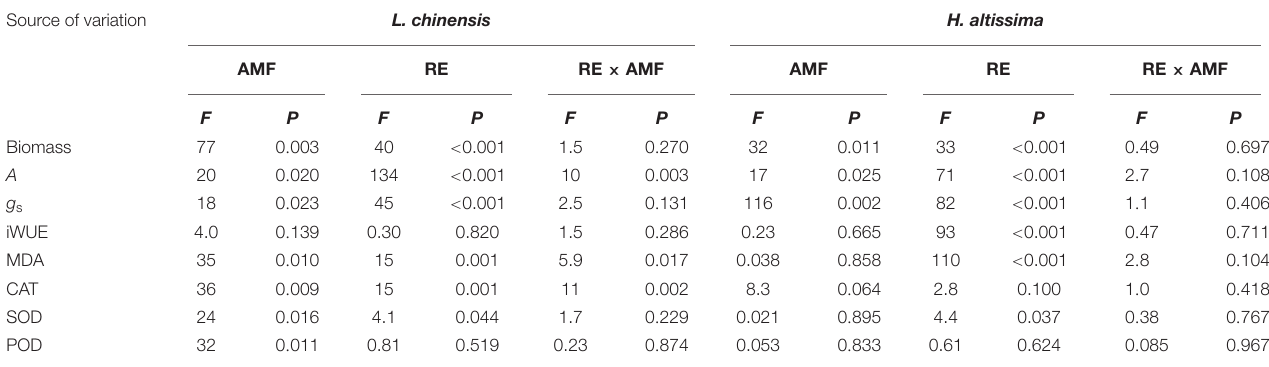
TABLE 1 | Results of two-way ANOVA on the effects of rainfall exclusion (RE), arbuscular mycorrhizal fungi (AMF), and their interactions on biomass, photosynthesis characteristic, contents of malondialdehyde (MDA), and antioxidant enzyme activities in L. chinensis and H. altissima . Source of variation